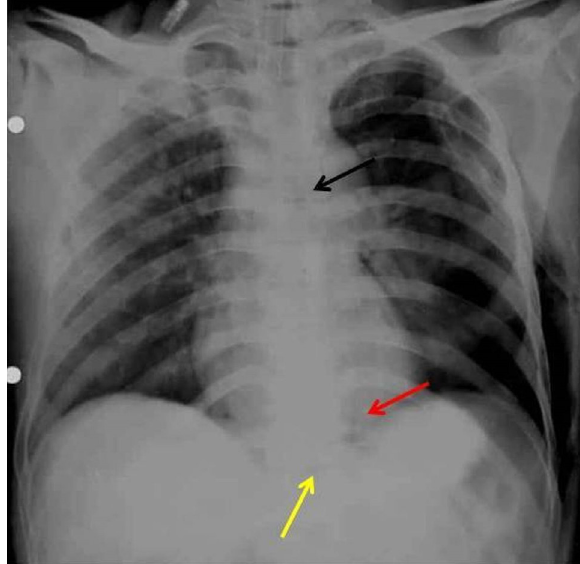
Figure 1. Frontal chest radiograph shows air outlining the mediastinal structures (black arrow). “V” shaped air collection is seen along the left lateral mediastinal border and left hemi diaphragm suggestive of “Naclerio V sign” (red arrow). Air is also seen beneath the central tendon of diaphragm (yellow arrow).